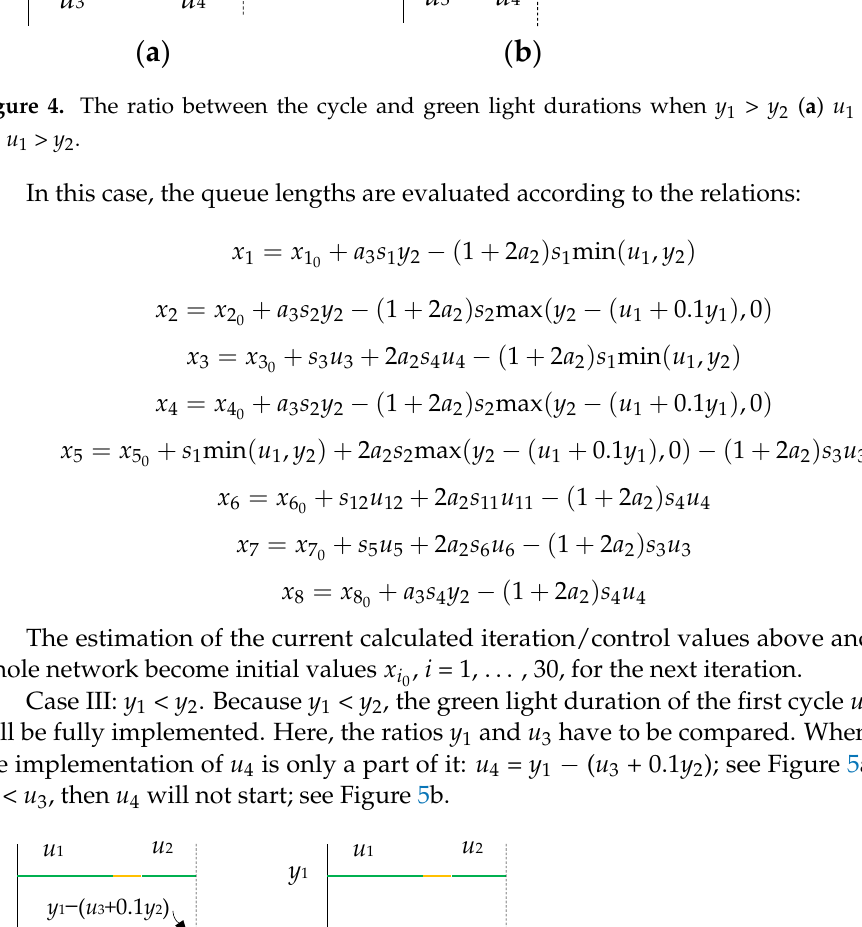
Figure 5. Ratio between cycle and green light durations when y 1 < y 2 , ( a ) u 3 < y 1 , and ( b ) u 3 > y 1 . In this case, the queue lengths are evaluated according to the relations: 𝑥 (cid:2869) = 𝑥 1 0 + 𝑎 (cid:2871) 𝑠 (cid:2869) 𝑦 (cid:2869) − (1 + 2𝑎 (cid:2870) )𝑠 (cid:2869) 𝑢 (cid:2869) 𝑥 (cid:2870) = 𝑥 2 0 + 𝑎 (cid:2871) 𝑠 (cid:2870) 𝑦 (cid:2869) − (1 + 2𝑎 (cid:2870) )𝑠 (cid:2870) 𝑢 (cid:2870) 𝑥 (cid:2871) = 𝑥 3 0 + 𝑠 (cid:2871) min (𝑢 (cid:2871) , 𝑦 (cid:2869) ) + 2𝑎 (cid:2870) 𝑠 (cid:2872) max ((𝑦 (cid:2869) − 𝑢 (cid:2871) − 0.1𝑦 (cid:2870) ),0) − (1 + 2𝑎 (cid:2870) )𝑠 (cid:2869) 𝑢 (cid:2869) 𝑥 (cid:2872) = 𝑥 4 0 + 𝑎 (cid:2871) 𝑠 (cid:2870) 𝑦 (cid:2869) − (1 + 2𝑎 (cid:2870) )𝑠 (cid:2870) 𝑢 (cid:2870) 𝑥 (cid:2873) = 𝑥 5 0 + 𝑠 (cid:2869) 𝑢 (cid:2869) + 2𝑎 (cid:2870) 𝑠 (cid:2870) 𝑢 (cid:2870) − (1 + 2𝑎 (cid:2870) )𝑠 (cid:2871) min (𝑢 (cid:2871) , 𝑦 (cid:2869) ) 𝑥 (cid:2874) = 𝑥 6 0 + 𝑠 (cid:2869)(cid:2870) 𝑢 (cid:2869)(cid:2870) + 2𝑎 (cid:2870) 𝑠 (cid:2869)(cid:2869) 𝑢 (cid:2869)(cid:2869) − (1 + 2𝑎 (cid:2870) )𝑠 (cid:2872) max ((𝑦 (cid:2869) − 𝑢 (cid:2871) − 0.1𝑦 (cid:2870) ),0) 𝑥 (cid:2875) = 𝑥 7 0 + 𝑎 (cid:2871) 𝑠 (cid:2871) 𝑦 (cid:2869) − (1 + 2𝑎 (cid:2870) )𝑠 (cid:2871) min (𝑢 (cid:2871) , 𝑦 (cid:2869) ) 𝑥 (cid:2876) = 𝑥 8 0 + 𝑎 (cid:2871) 𝑠 (cid:2872) 𝑦 (cid:2870) − (1 + 2𝑎 (cid:2870) )𝑠 (cid:2872) max ((𝑦 (cid:2869) − 𝑢 (cid:2871) − 0.1𝑦 (cid:2870) ),0) .